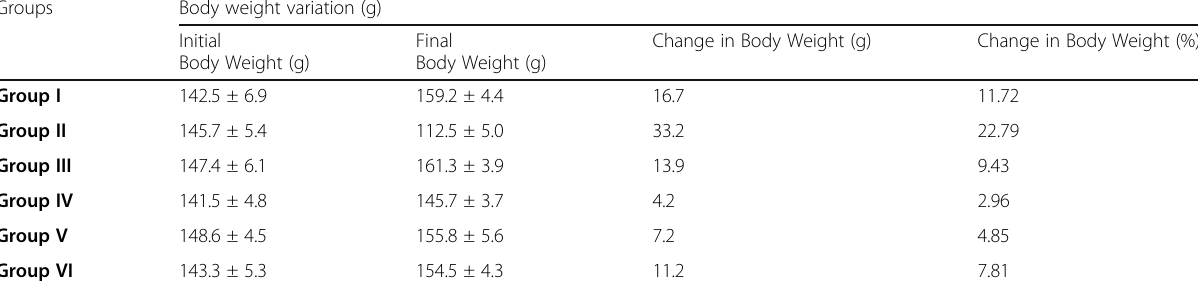
Table 1 Effect of CRME on body weight variation Groups